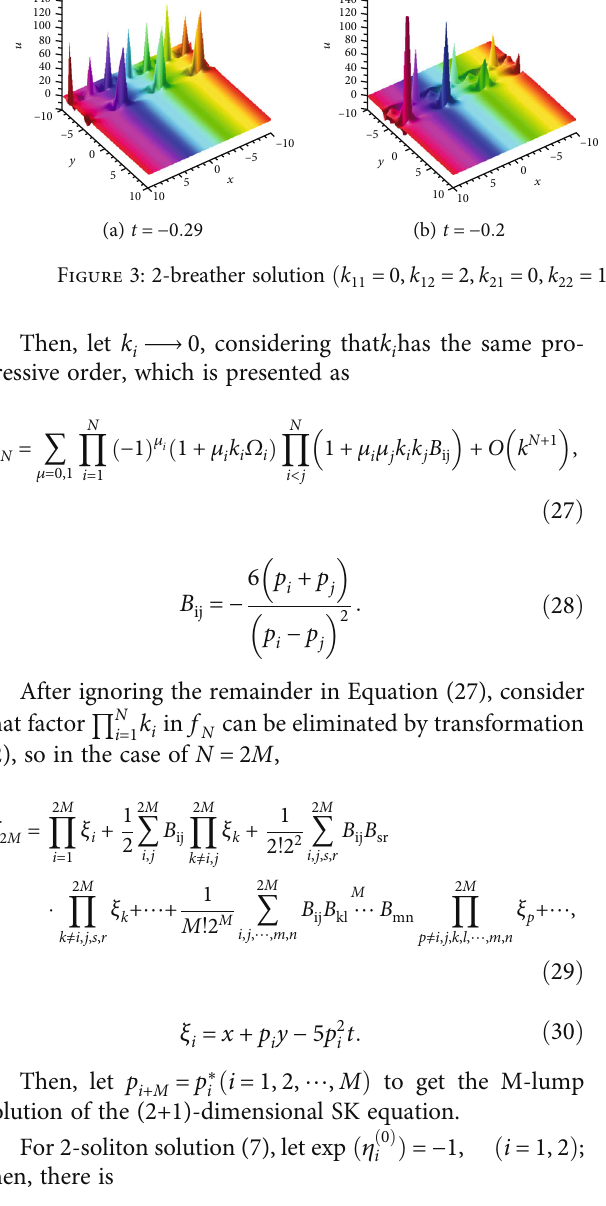
Figure 3: 2-breather solution ð k